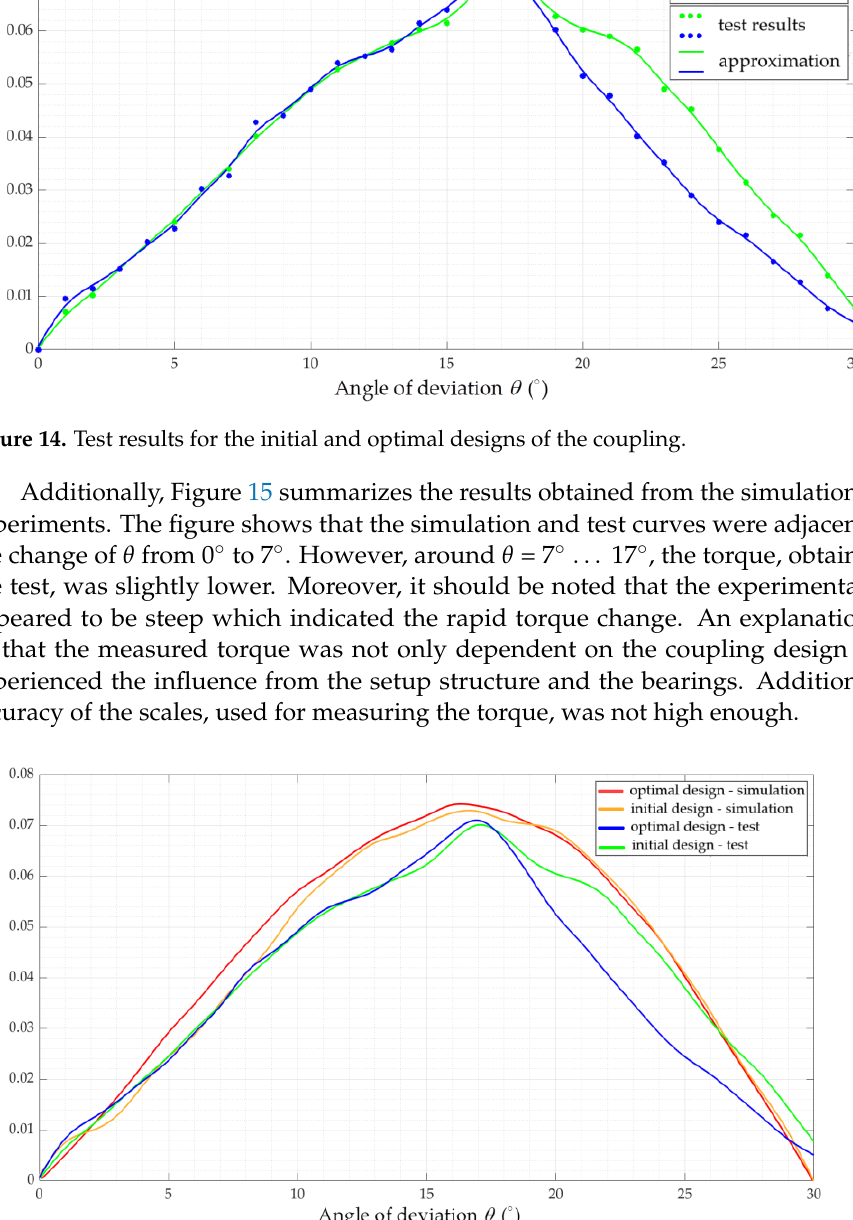
Figure 15. Comparison of simulation and experimental results for the initial and optimal designs of the coupling.